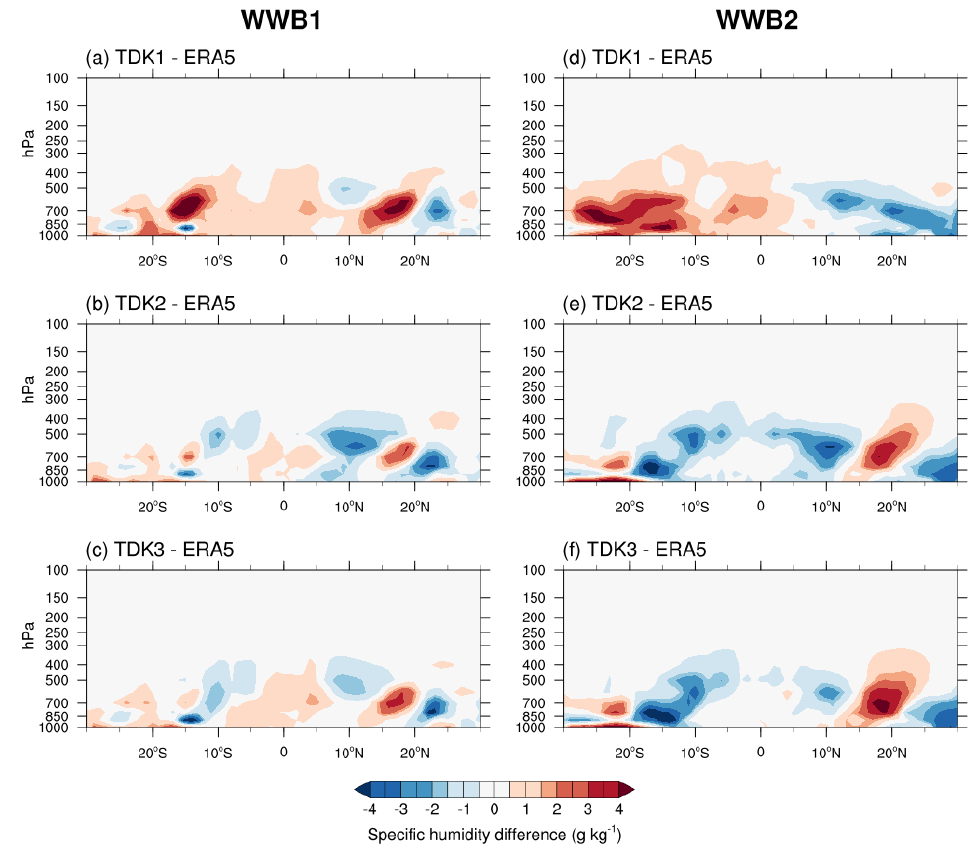
Figure 11. Pressure-latitude diagrams of the specific humidity difference (g kg − 1 ) between all experiments and the ERA5 reanalysis. Data are averaged between 105 ◦ E and 120 ◦ E. The left (right) panel displays two-day averaged results when the WWB1 (WWB2) convective center is located near 90 ◦ E.